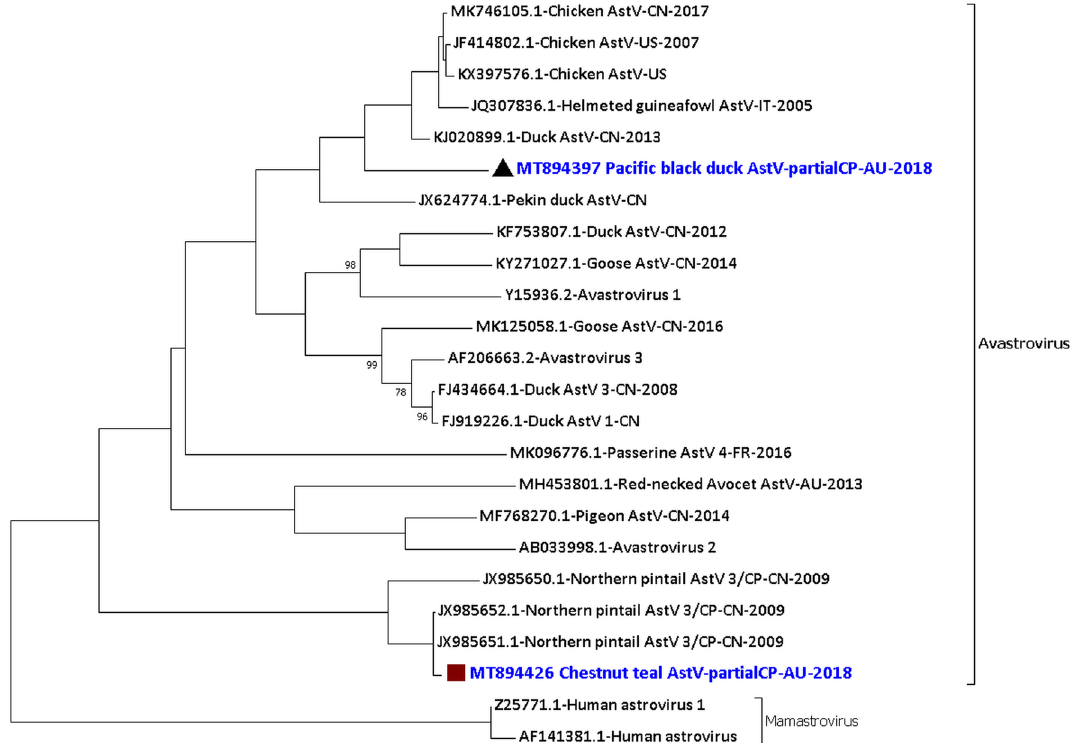
Figure 5. Phylogenetic analysis of the amino acid sequences of the partial capsid protein (ORF2) of Pacific black duck avastrovirus (PBDAstV/1297nt/PBD05.18) and Chestnut teal avastrovirus (CTAstV/1564nt/ CT11.18). The amino acid sequences were aligned and analysed by using the maximum likelihood method based on the LG + G model 72 in MEGACC 74 with a bootstrapping of 1000 replicates. The analysis involved 24 amino acid sequences and all positions containing gaps and missing data were eliminated. The final dataset contained a total of 224 amino acid positions. The numbers at the nodes represent bootstrap values and only bootstrap values at or above 60% are shown. Pacific black avastrovirus is shown in blue and marked with a black triangle and Chestnut teal avastrovirus is shown in blue and marked with a brown